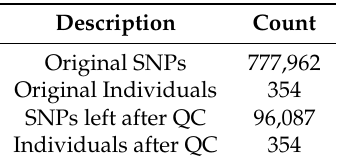
Table 1. Statistical summary of all single nucleotide polymorphism (SNP) loci and individuals before and after quality control (QC).